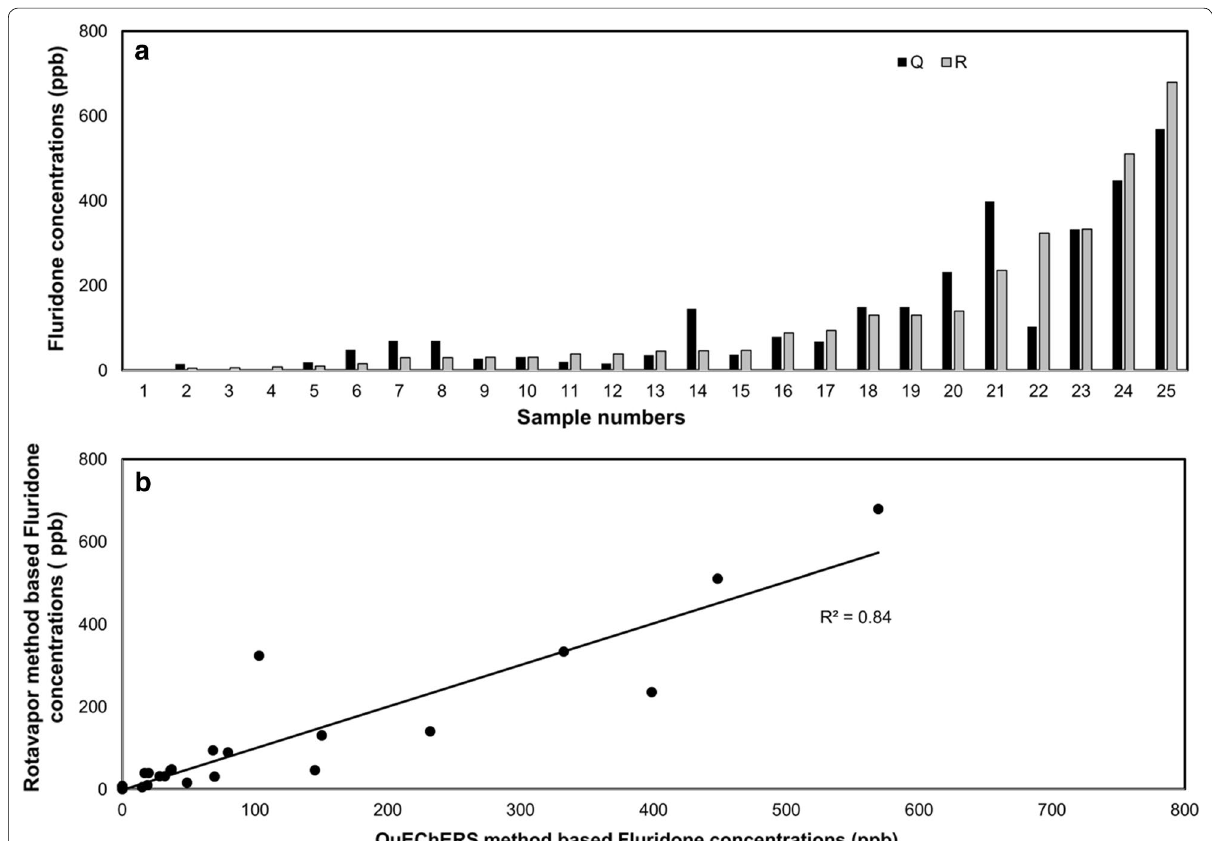
Fig. 5 Relative performance of sediment extractions methods on field samples: a fluridone concentrations in sediment [ Q QuEChERS method, R rotavapor method]; b comparison between results of rotavapor method (RM) and QuEChERS method (QM)